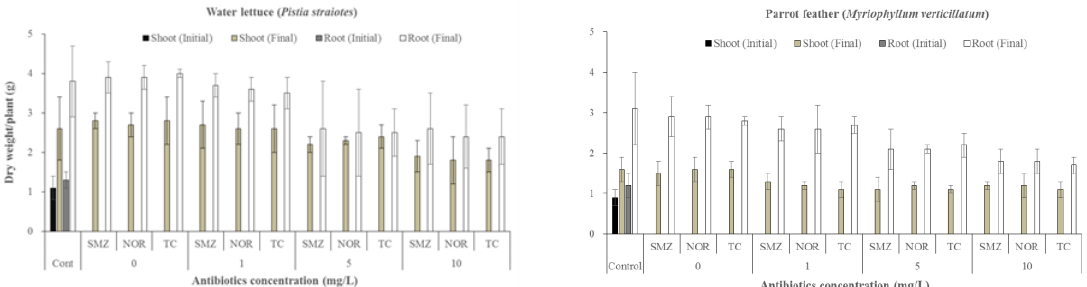
Figure 1. Dry weights of water lettuce and parrot feather under various treatments at the end of the experimental period.